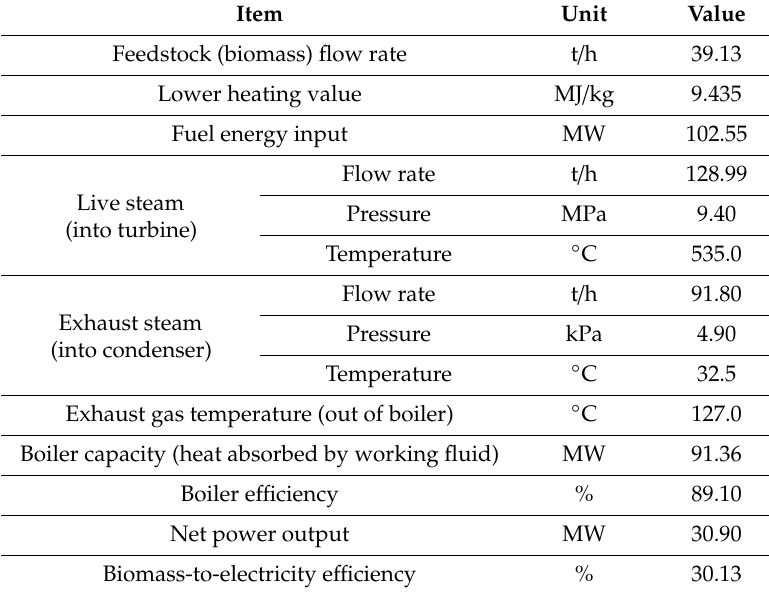
Table 5. Parameters of the heat regeneration system in the reference biomass-fired power plant.